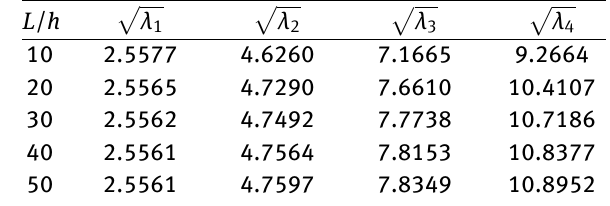
Table 19: Frequency parameter length-to-height ratio L / h